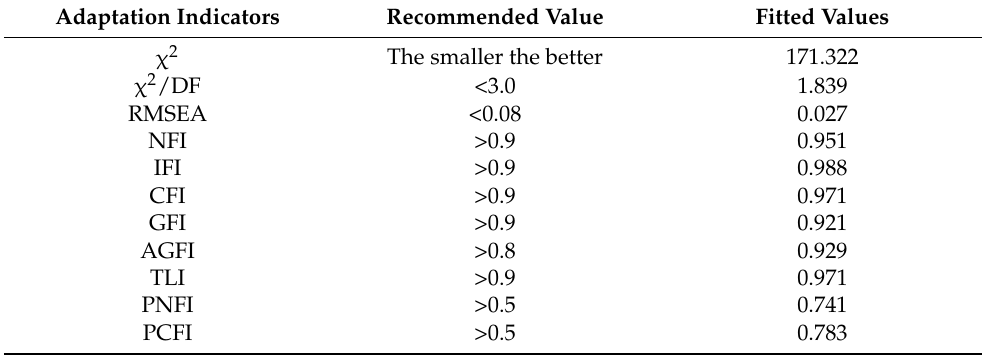
Table 3. Model fitness test